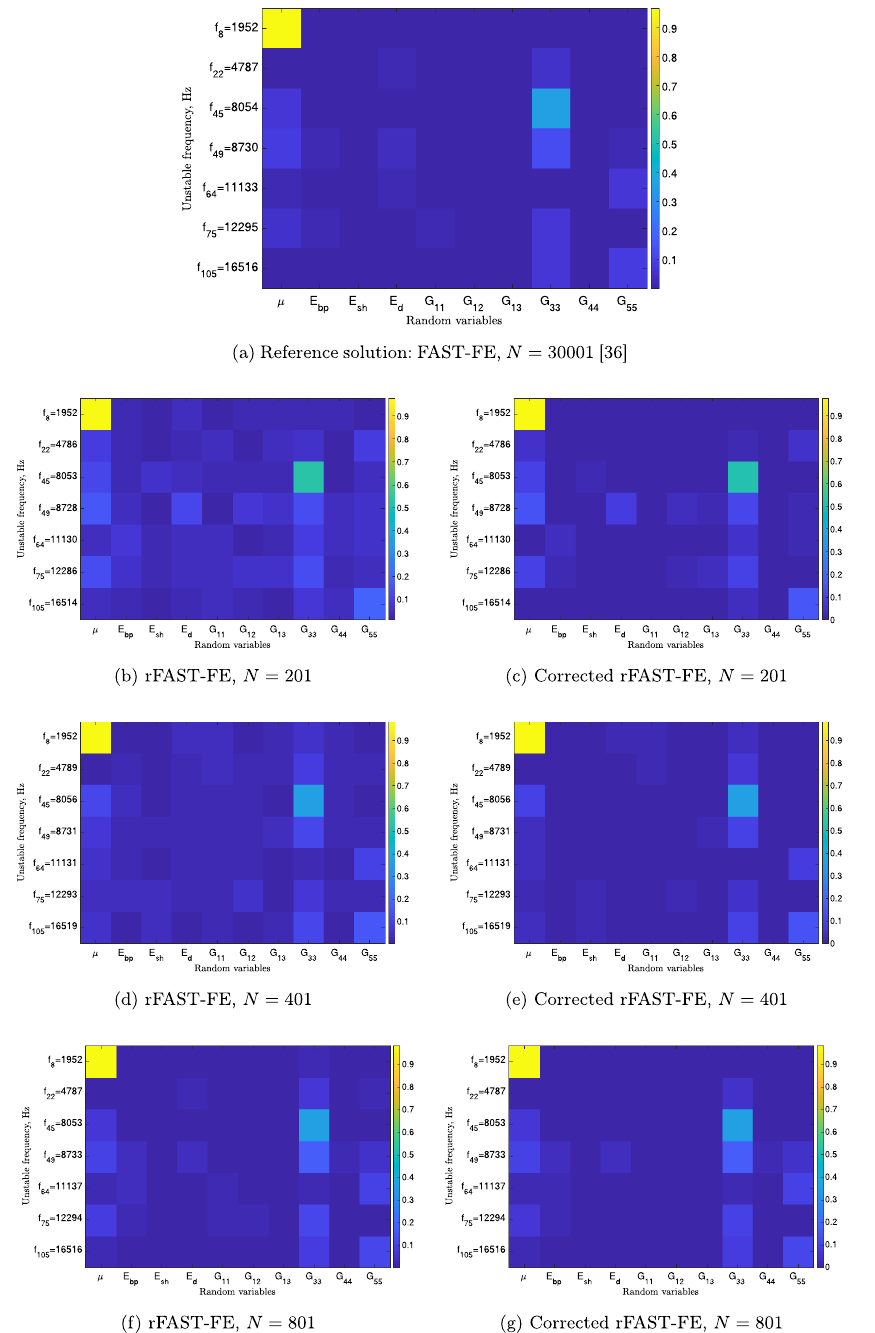
Fig. 7 Design mapping results—effect of the sample size N and the weighted correction on the response design map: Top, a represents the reference solution predicted by FAST-FE approach using 30 , 001 iterations. The second, third and fourth lines show a comparison of rFAST-FE prediction with the corrected one for a sample size of 201 ( b , c ), 401 ( d , e ) and 801 ( f , g ),